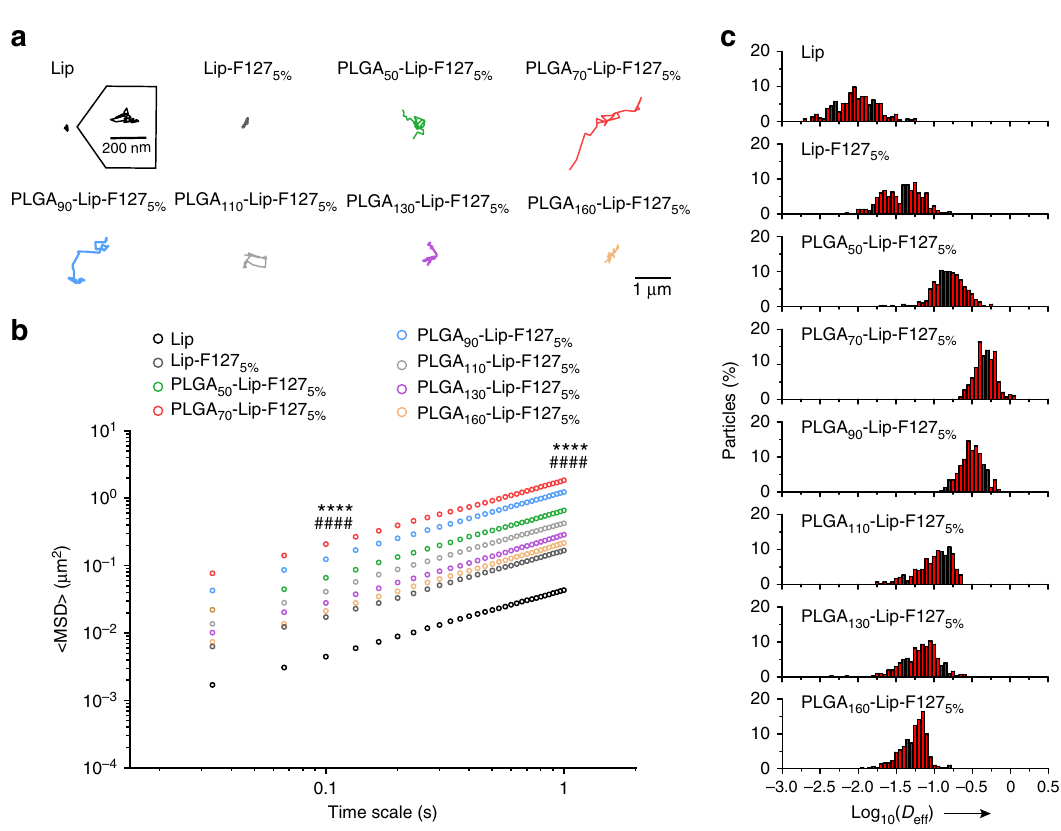
Fig. 2 Transport of NPs with various rigidities in rat mucus ex vivo. a Representative trajectories of particle motion in 1 s in fresh rat intestinal mucus. b <MSD> values as a function of time for particles in mucus. c Distributions of the logarithms of individual particle effective diffusivity ( D eff ) values in mucus on a time scale of 1 s. The data represent three independent experiments, with each experiment tracking 100 NPs. **** P < 0.0001, PLGA 70 -Lip- F127 5% compared to Lip-F127 5% , and #### P < 0.0001, PLGA 70 -Lip-F127 5% compared to PLGA 160 -Lip-F127